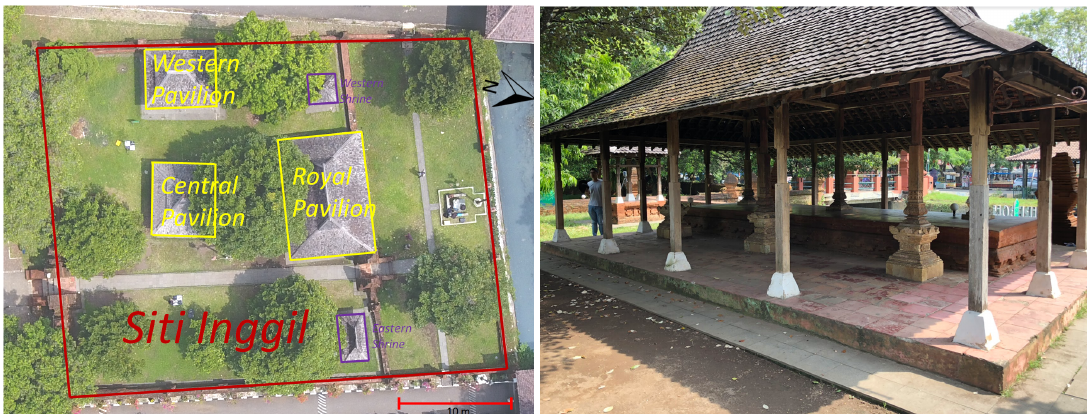
Figure 1. The area of Siti Inggil within the palace compound, which was documented in higher detail. To the left, an aerial view of the area with several main structures overlaid. To the right, the Royal Pavilion of the Siti Inggil compound. Note the characteristic tropical architecture in the form of double-tiered roofs and the absence of